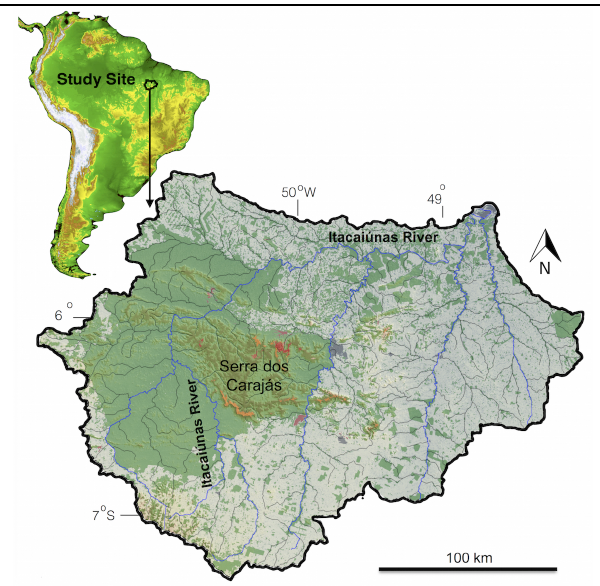
Figure 1. Location map of the study site illustrated in the 2013 land cover and land use map generated from interpretation of the Landsat-8 OLI images. Green = forest, orange = montane savanna, belge = pastureland, red = mining area, grey = urban area, blue line = main rivers, thin black line = secondary rives, bold line = watershed boundary.